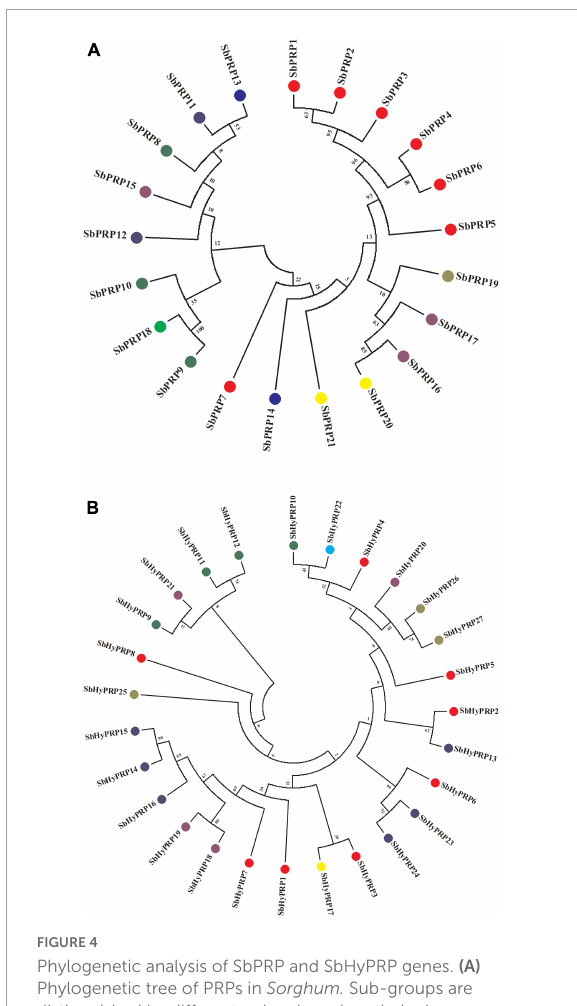
FIGURE4 Phylogenetic analysis of SbPRP and SbHyPRP genes. (A) Phylogenetic tree of PRPs in Sorghum. Sub-groups are distinguished by different colors based on their chromosome locations, (B) phylogenetic tree of HyPRPs in Sorghum . Sub-groups are distinguished by different colors based on their chromosome